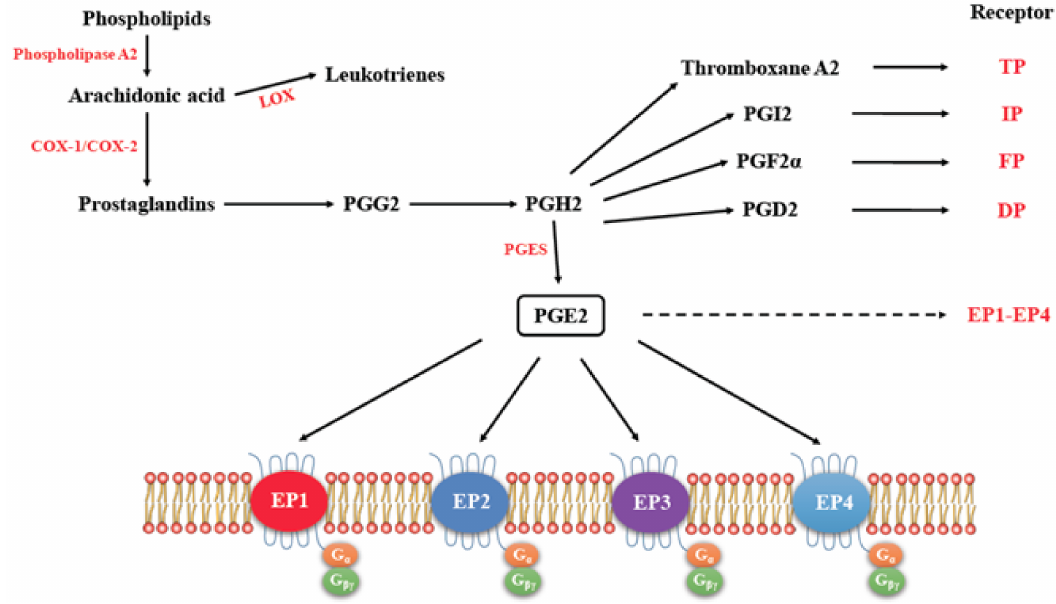
Figure 1. The pathway for the synthesis of prostaglandins, their respective receptors and signaling. (Adapted with kind permission from Markoviˇc, T.; et al. 2017; reference [9]). Arachidonic acid acts as the substrate for cyclooxygenase (COX)-1 and COX-2 to produce Prostaglandins PGE2, Thromboxane A2, PGI2, PGF2 α , and PGD2, all of which exert functions by binding to their respective receptors. EP1-EP4 (dashed arrow) receptors are further detailed for their G protein